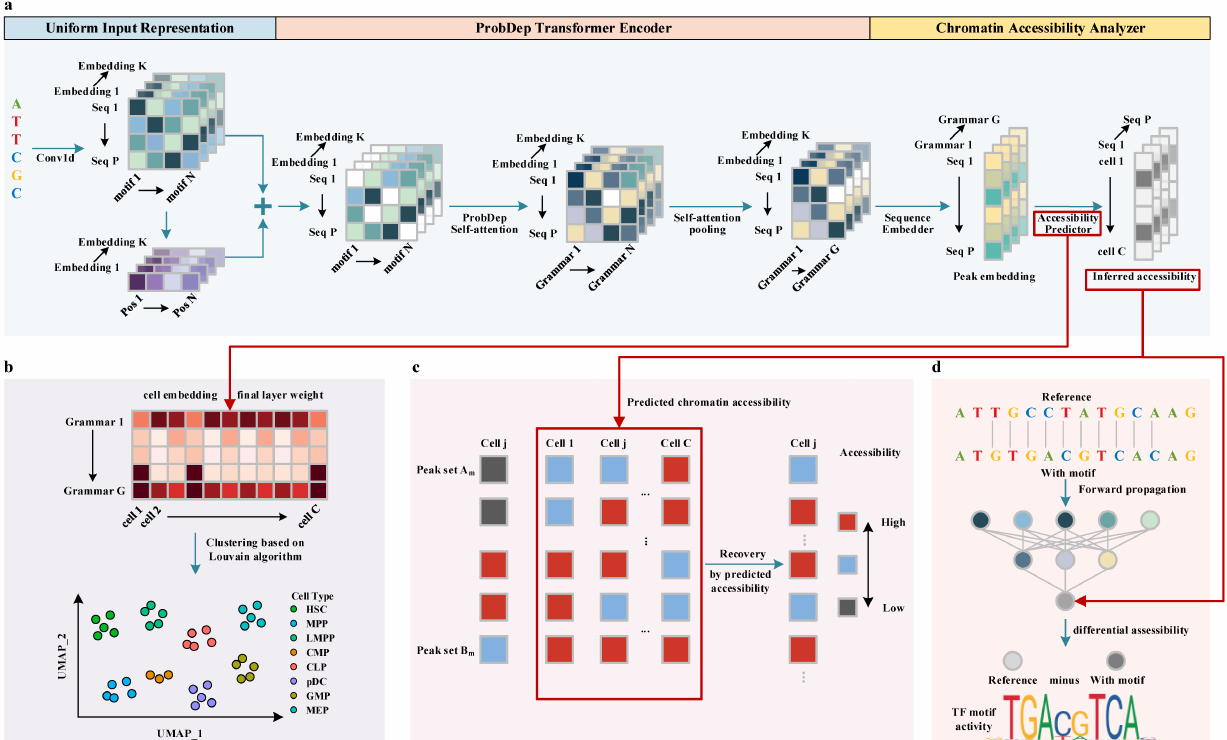
Figure 1. The overview of PROTRAIT. ( a ) Chromatin accessibility modeler. This module comprises a Uniform Input Representation, a ProbDep Transformer Encoder, and a Chromatin Accessibility Analyzer. Specifically, Uniform Input Representation encodes each regulatory motif’s occupancy and position information. ProbDep Transformer Encoder further captures bona fide long-range de- pendency between different regulatory motifs. Chromatin Accessibility Analyzer integrates learned regulatory grammars to predict the chromatin accessibility of each cell. The final layer weight of the Chromatin Accessibility Analyzer can be regarded as cell embedding. ( b ) Cell type annotator. After generating cell embedding, this module utilizes the Louvain algorithm to perform single-cell cluster- ing for cell type annotation. ( c ) scATAC-seq data denoiser. This module utilizes a statistical model to discover which zero counts are affected by dropout events. It only performs recovery on discovered zero counts by predicted chromatic accessibility. ( d ). TF activity analyzer. This module analyzes